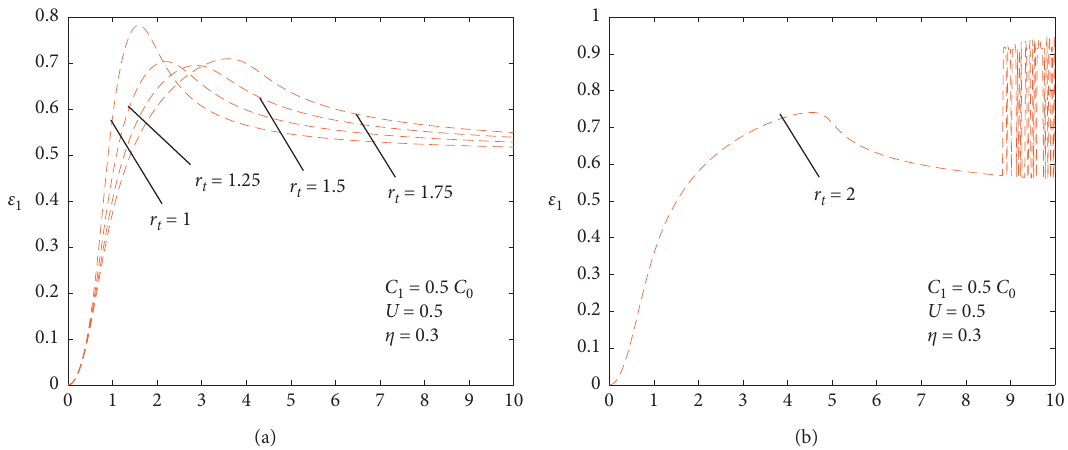
Figure 9: The influence of r t on the unbalance response of the rotor-DCSFD system: (a) stability; (b) instability.